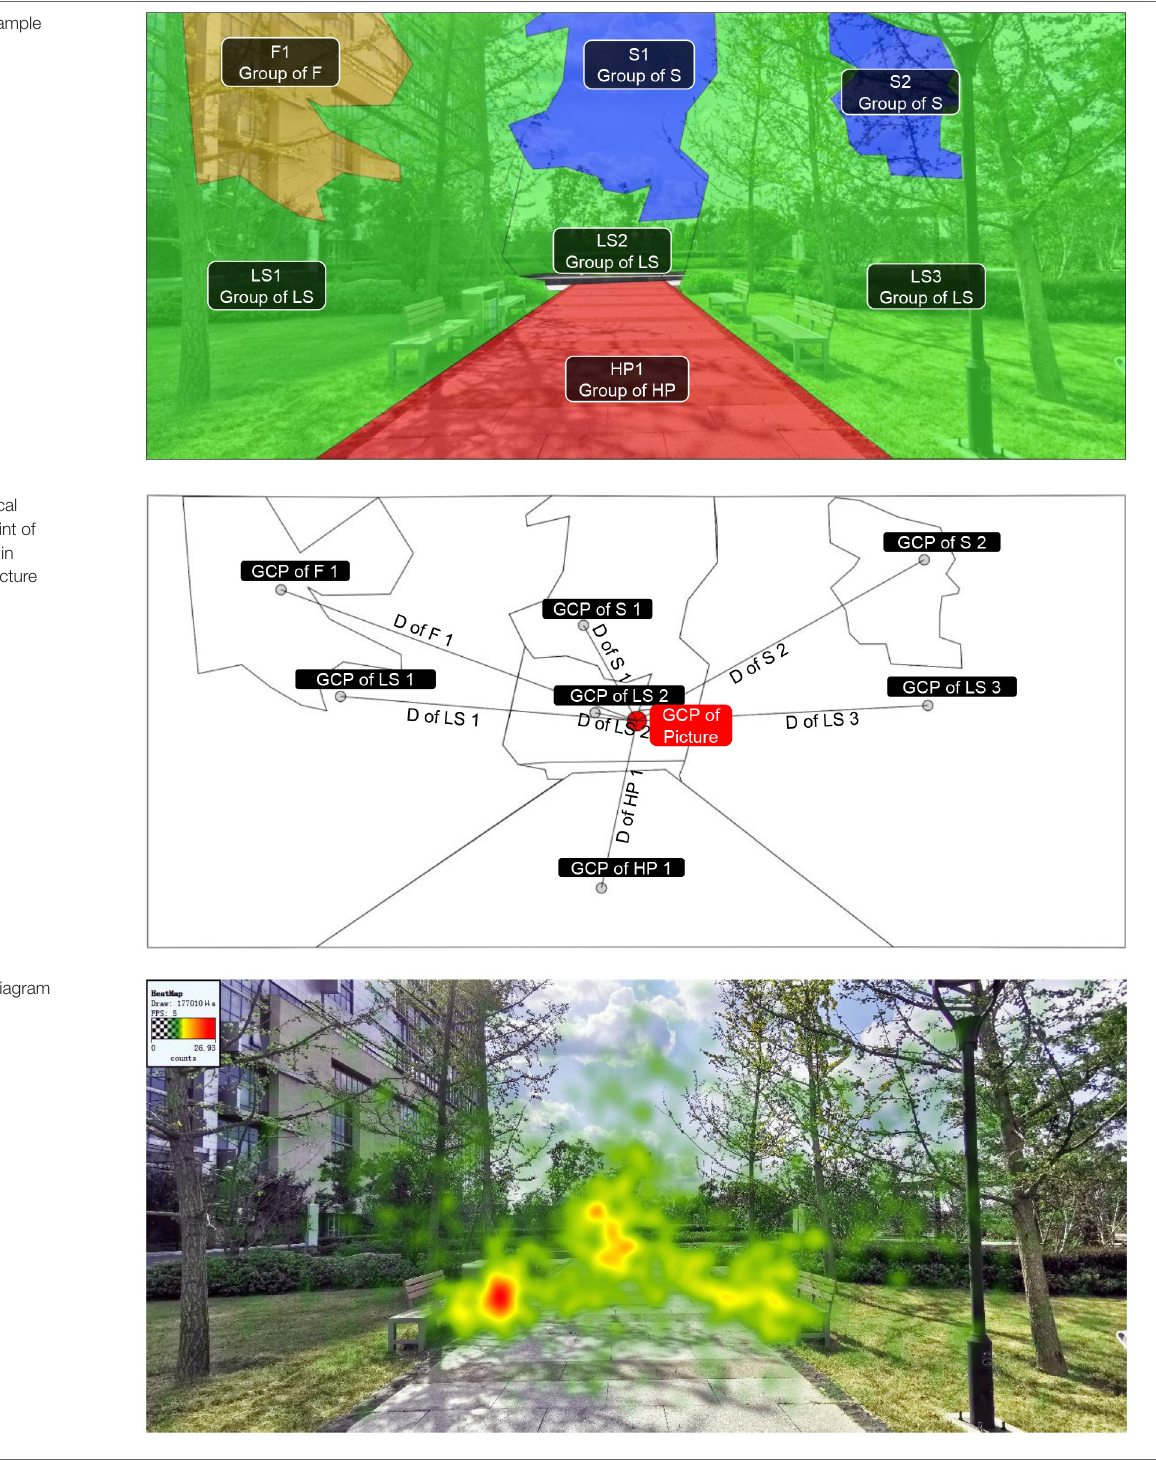
TABLE 3 | AOIs, geometrical center points and fixation diagram of sample